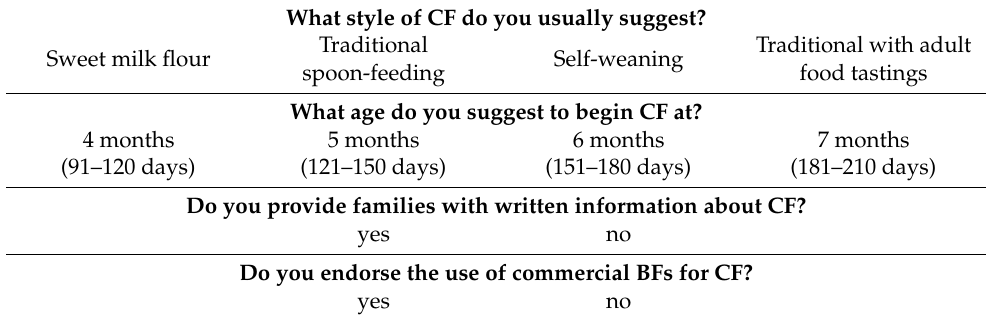
Table 1. Multiple-choice questionnaire sent to